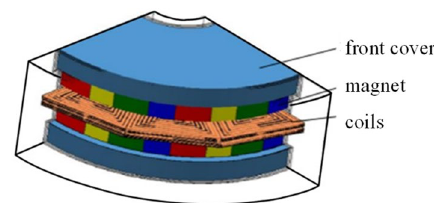
Figure 23 Simulation model of AFPMSM with PCB stator